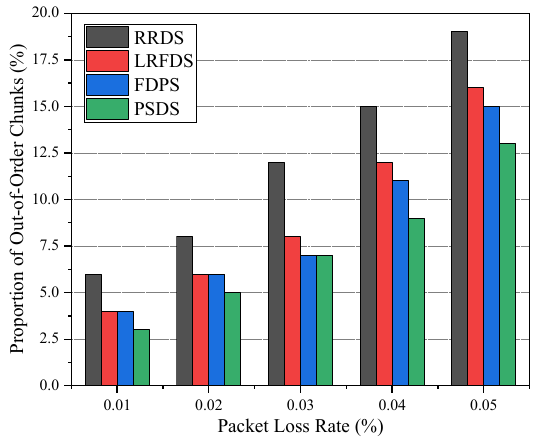
Figure 8. Proportion of out-of-order chunks under different packet loss rates.